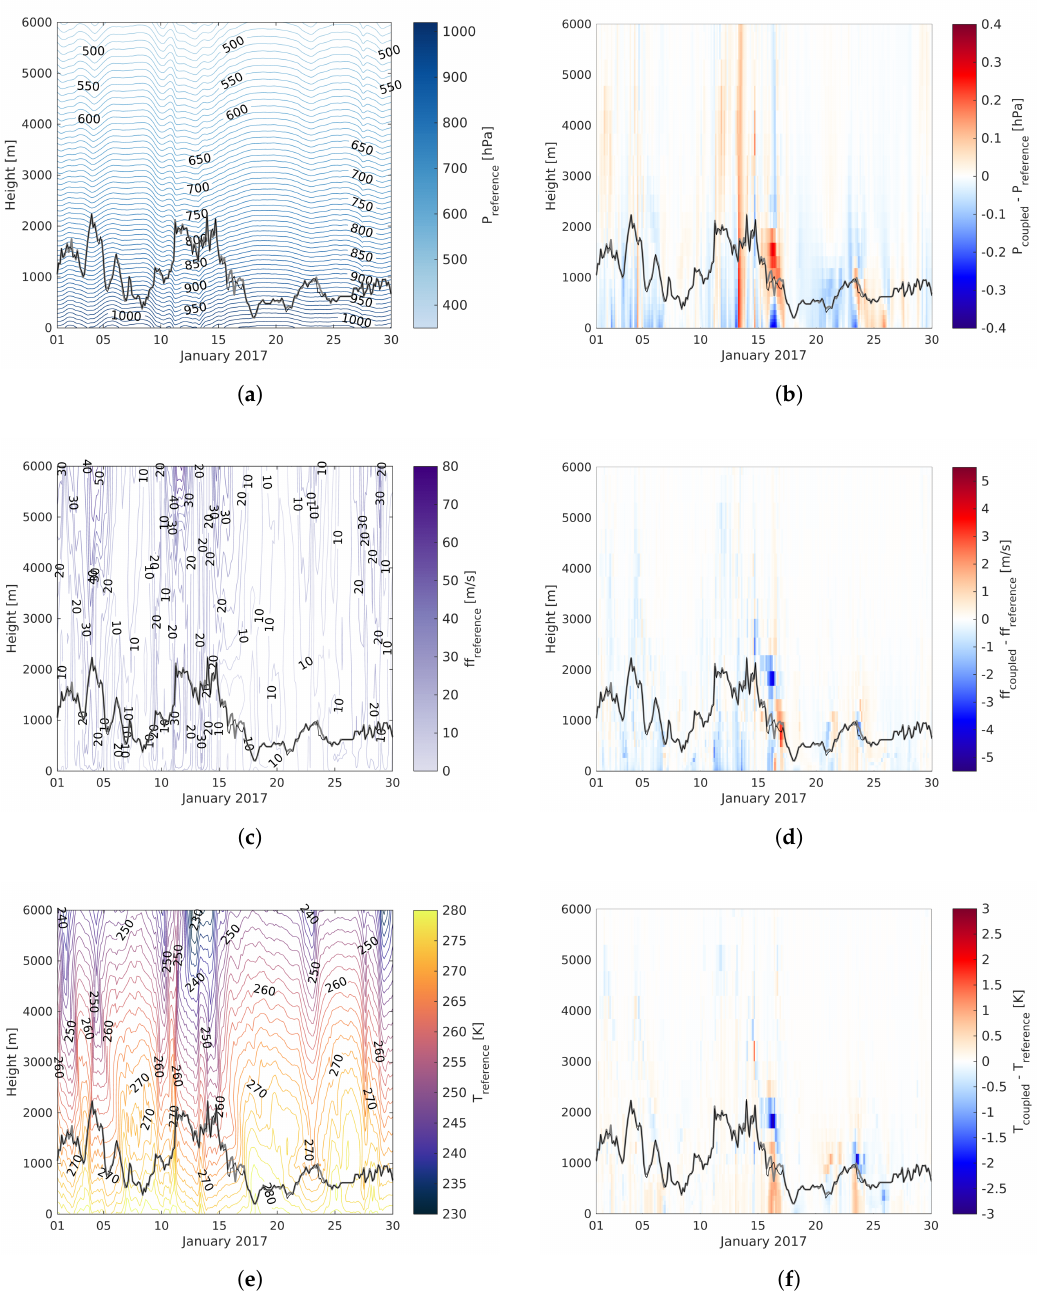
Figure 7. Hovmöller diagrams ( a , c , e ) of the results from the reference model simulation and ( b , d , f ) of the differences between the reference and coupled model simulations in the North Sea for January 2017 for the ( a , b ) air pressure, ( c , d ) wind speed and ( e , f ) temperature. The black lines indicate the planetary boundary layer (PBL) height in the reference model simulation, and the grey lines indicate the PBL height in the coupled model